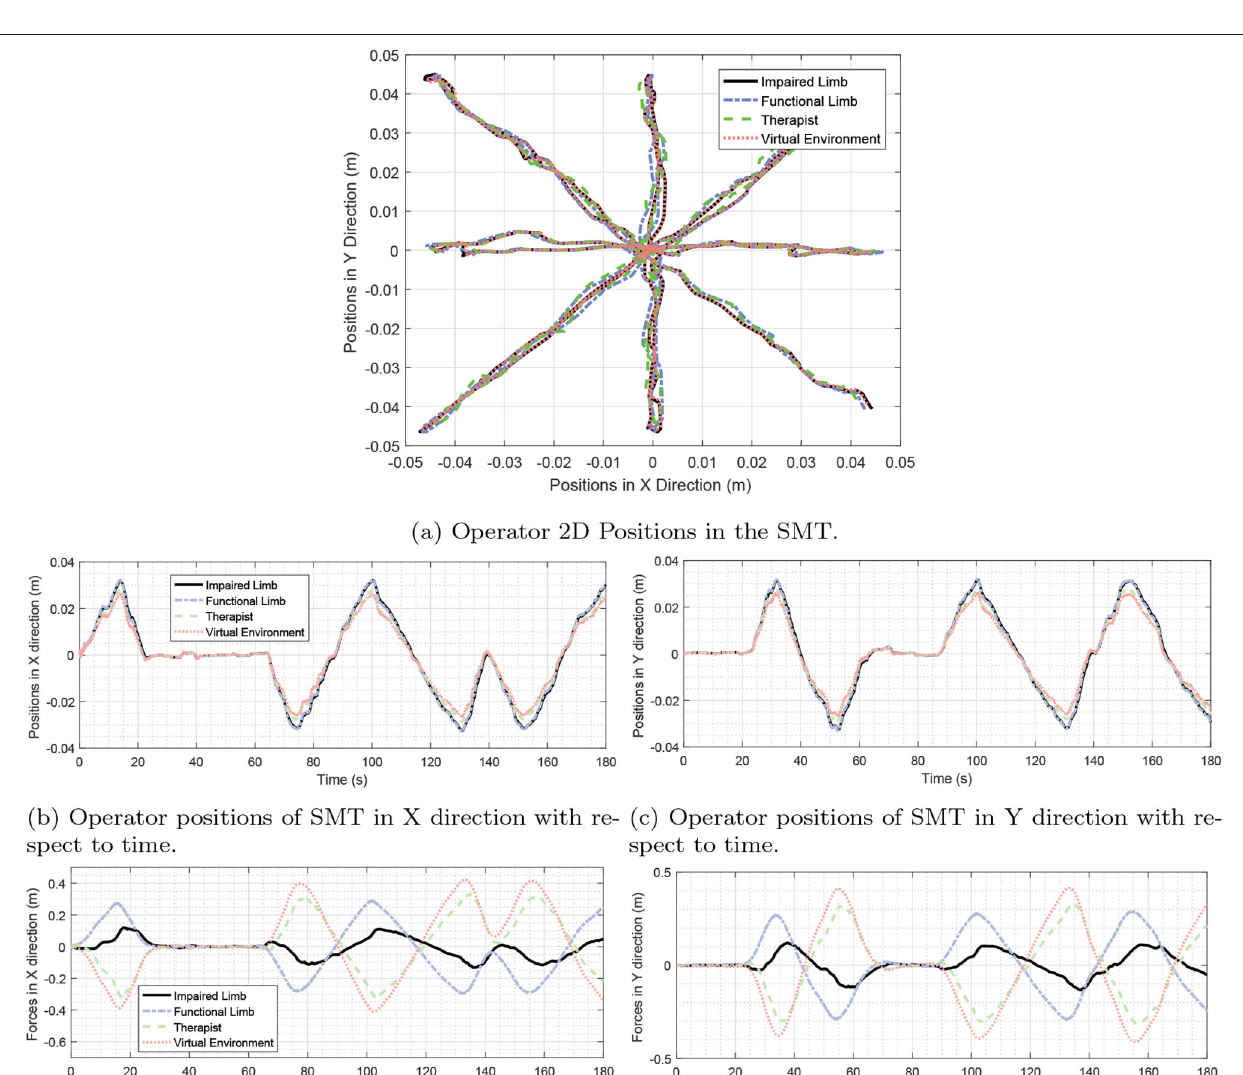
FIGURE 11 | SMT experimentation. Participants in this TR process include a therapist, a functional hand, and impaired hand. Also, the virtual environment as the last operator in this process cooperates with other operators. As shown in the figure, there is a star path for users to move. Part (a) Shows the movement of the operators in two dimensions and part (b,c) show the movement of the operators in the X and Y dimensions separately. Sections (d,e) also show the force of the operators in the x and y directions. As can be seen, according to Equation (51), the sum of the forces in each case will be close to